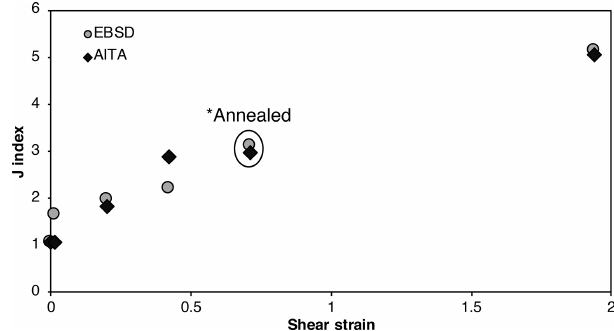
Figure 3. c axis texture (CPO) index J i determined from AITA and EBSD data for all the shear strains investigated. Annealed sample TGI0.71 is highlighted for